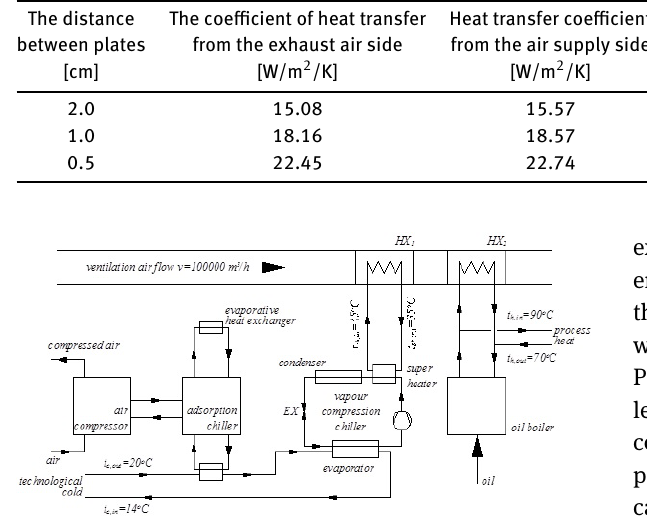
Table 3: The calculation results for the plate heat exchanger.